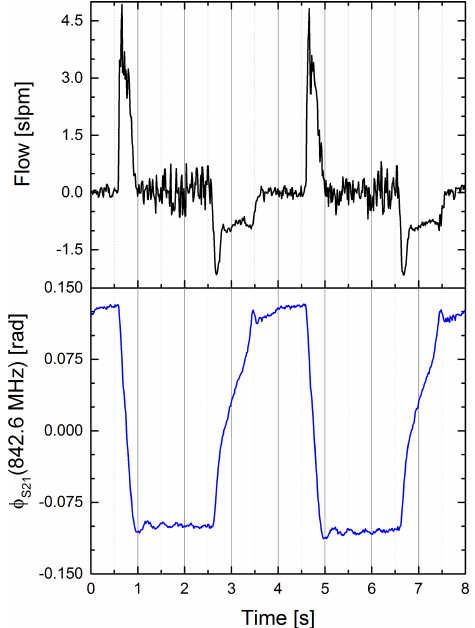
Figure 7. Airflow (black) and phase of the S 21 parameter at a fixed frequency (blue) vs. time. Clearly visible is the differing signal shape (Pearson coefficient = − 0 . 0134). We assume the difference is caused by different proportionalities. The S 21 is proportional to the water volume in the upper compartment, whereas the flow is proportional to the change of air in the lower compartment. Also visible is the synchrony of the signals.